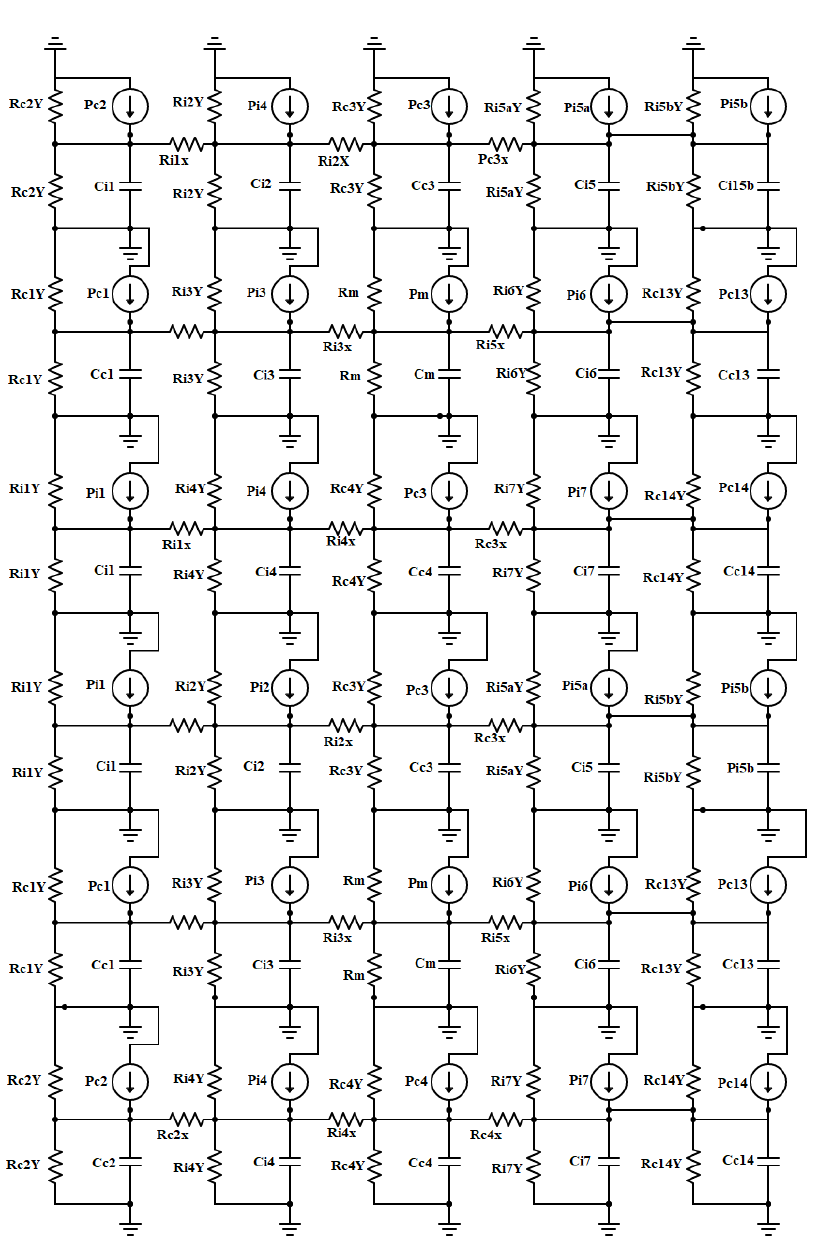
Figure 28. LPMC model of the